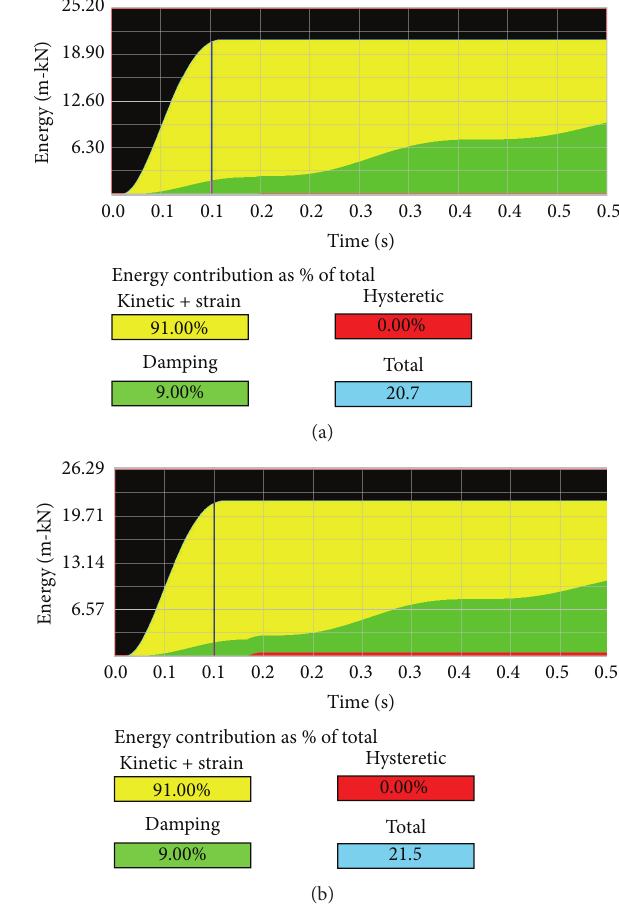
Figure 8: Blast load with 18m explosion distance: (a) uncorroded shear wall and (b) corroded shear wall.